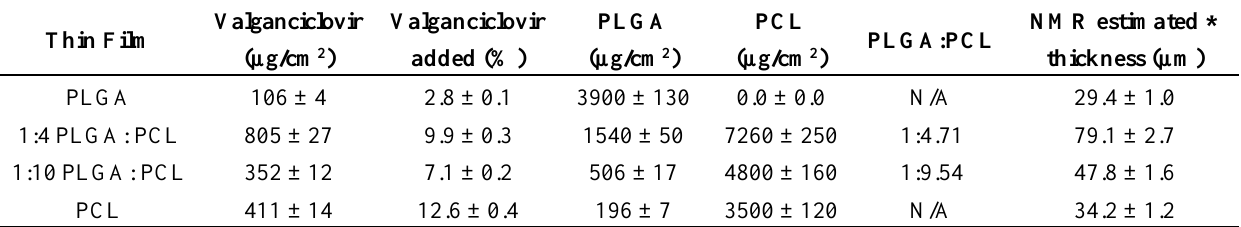
Table 1. NMR quantification of the valganciclovir polymer films. Thin